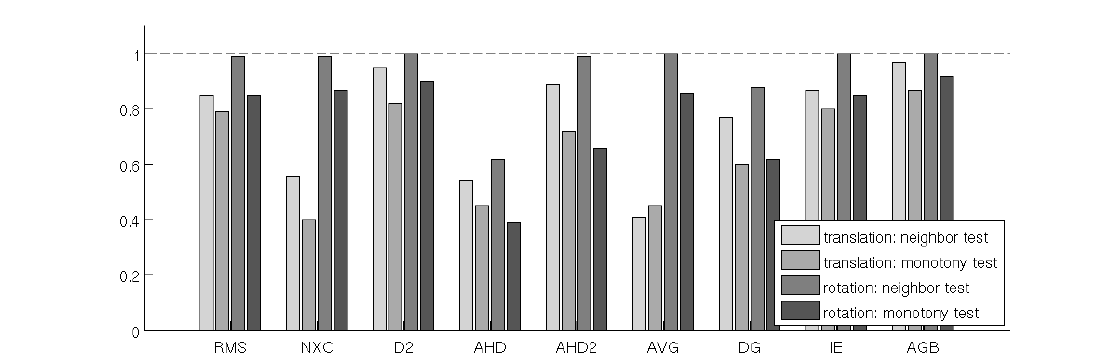
Figure 6. Fractions of passed neighbor tests and monotonic tests for 100 series of translated and rotated